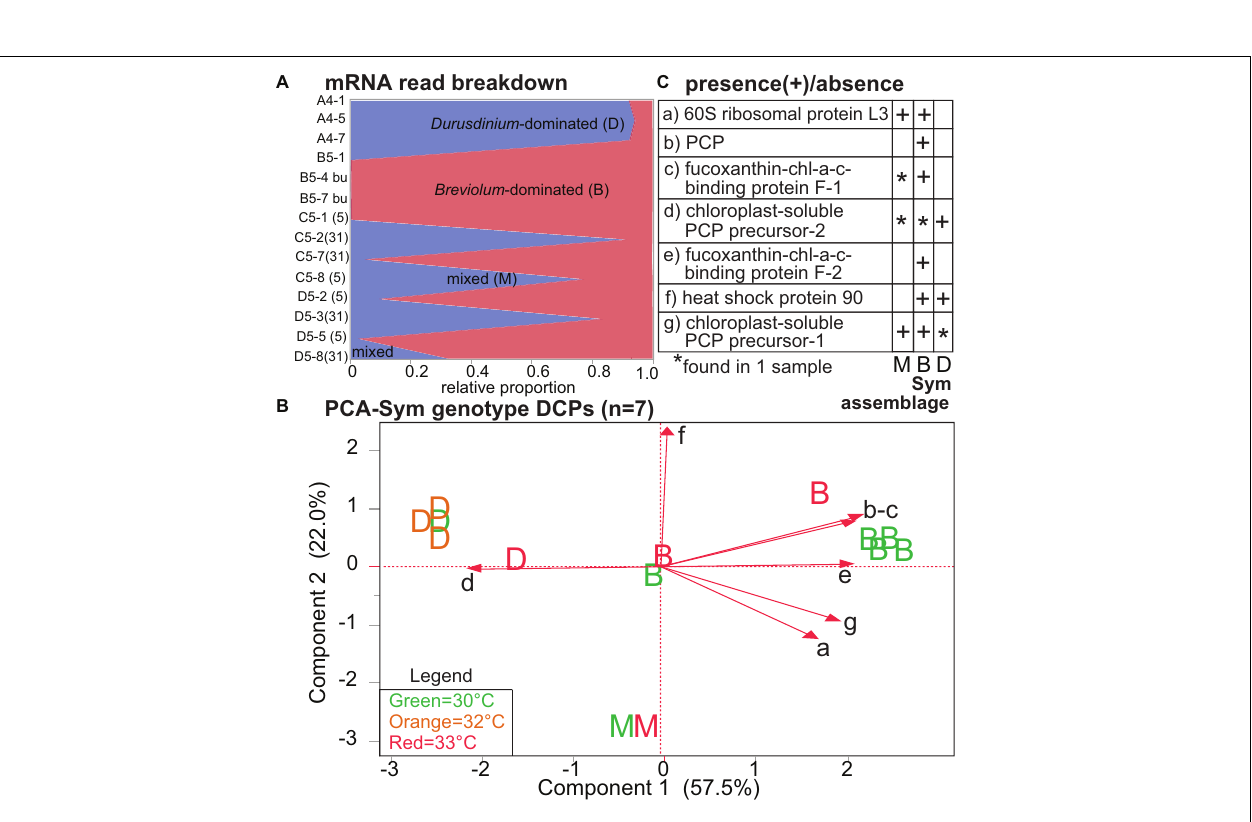
Frontiers in Marine Science |